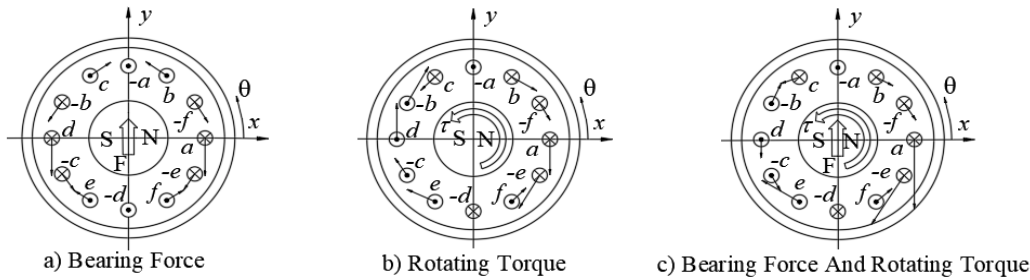
Figure 5. Generation of bearing force and rotating torque.